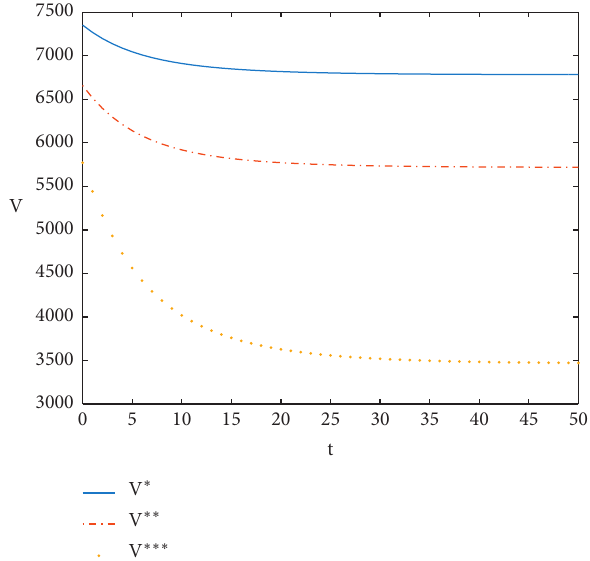
Figure 6: Comparison of total environmental pollution losses in the